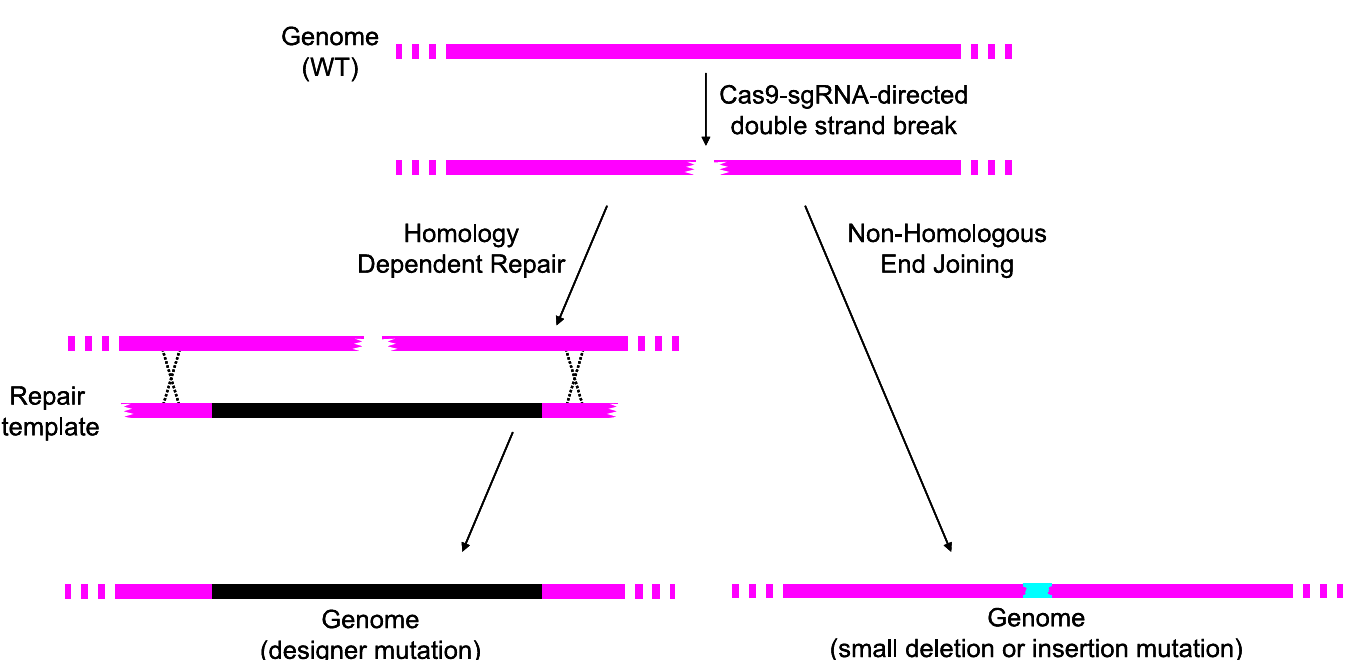
Fig 1. Outcomes of Cas9-single guide RNA (sgRNA) cleavage at a genomic site. The Cas9-sgRNA complex is able to target a double-strand break in DNA to a specific site in the genome. The break is repairedby cellularmachinery to generatea mutation that alters the site, thus preventingrepeated cleavage.If the cell has a template that has homology to both sides of the break (left side of panel),then the template can be used by homology-dependent repair. For genomeengineering, the investigator introduces into cells a custom template along with sources of Cas9 and the relevant sgRNA to create a designermutation. Such mutations may be small changesin nucleotidesequenceor a large insertionor deletion. Alternatively,the cell can use nonhomologous end joining(right side of panel)to create small insertions or deletionsat the cut site.